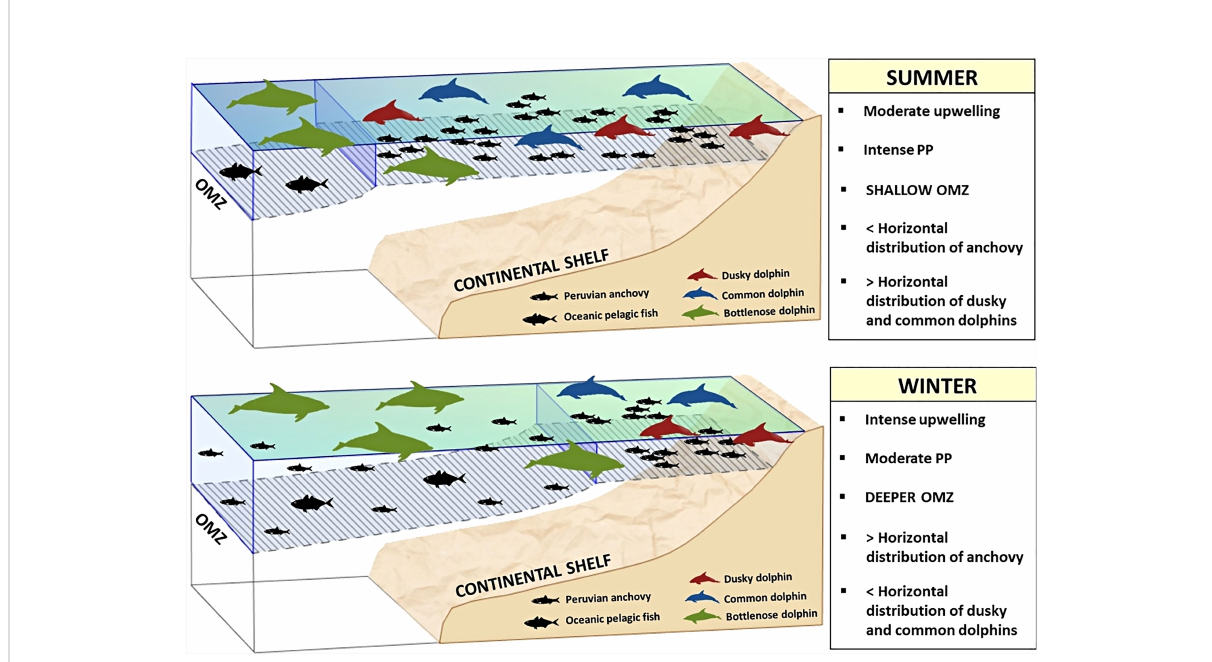
FIGURE 7 Conceptual model of habitat suitability of dusky, common, and bottlenose dolphins in the northern Humboldt Current System. Two contrasting seasons (summer and winter) are shown to represent differences in the species spatial distribution, mainly over the continental shelf. PP: Primary productivity. Dolphin shapes were modi fi ed from those of Chris Huh